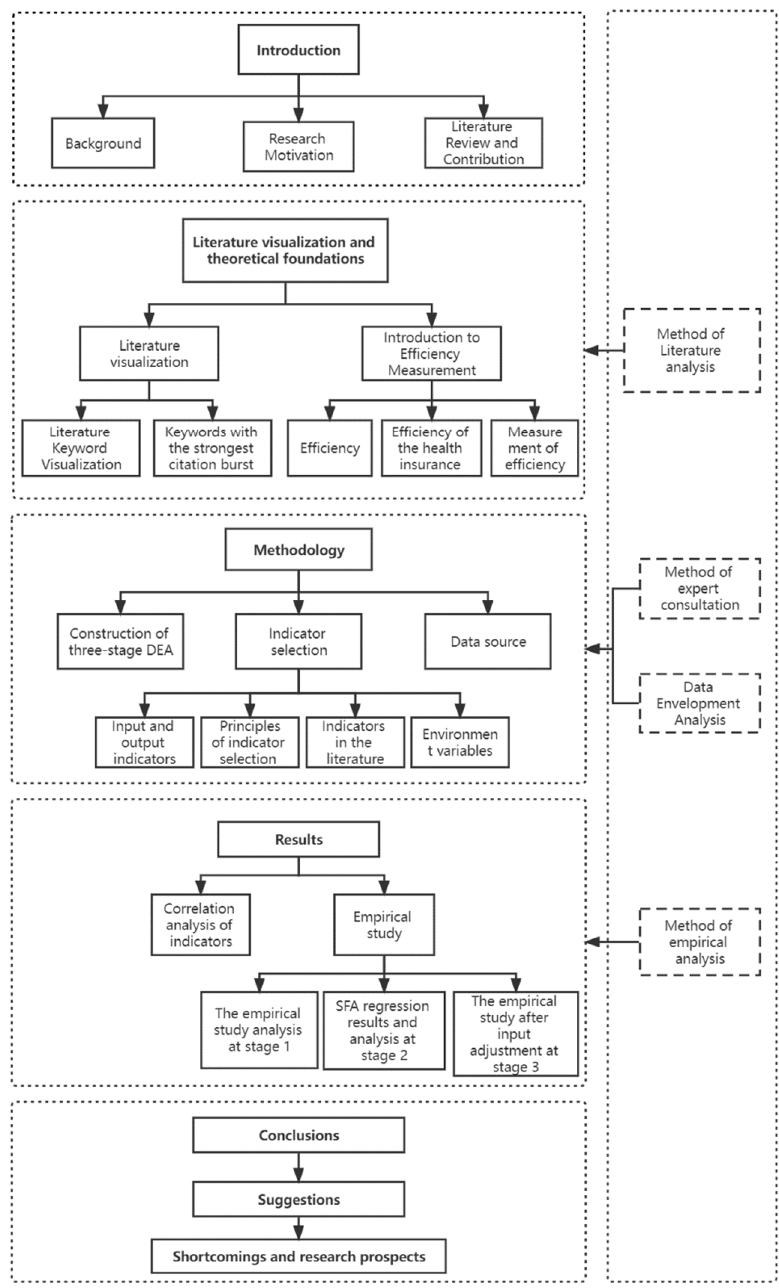
Figure 1. Research